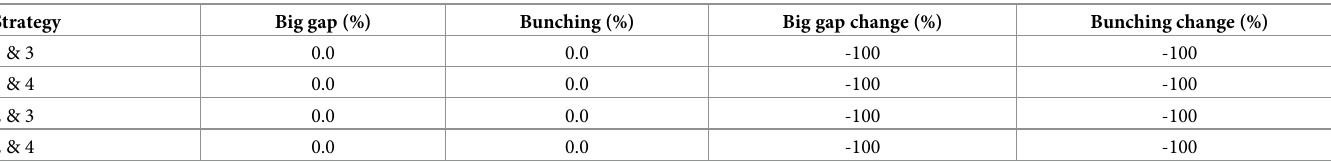
Table 17. Effect of combination of strategies on big gap and bunching.